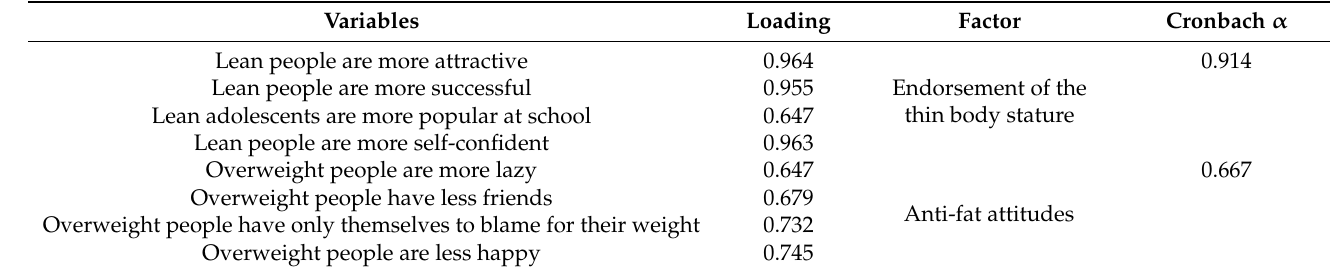
Table 1. Factor analysis results on body weight